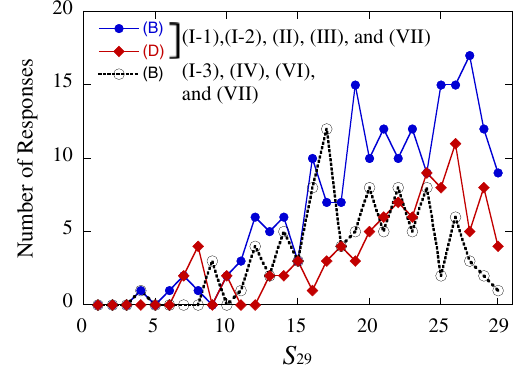
FIG. 2. Score distribution of (B) choosers and (D) choosers with different